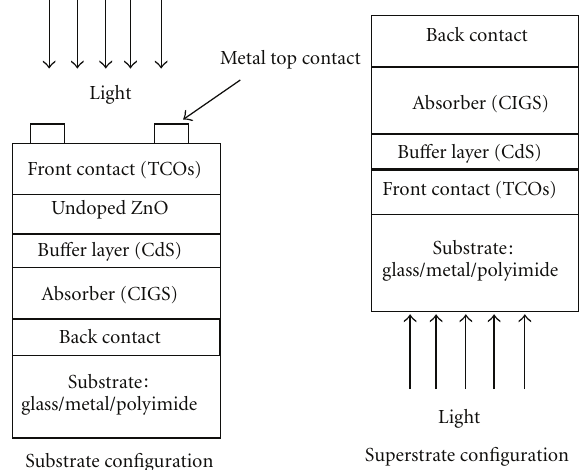
Figure 3: Schematic cross-section of “substrate” and “superstarte” configuration of CIGS solar